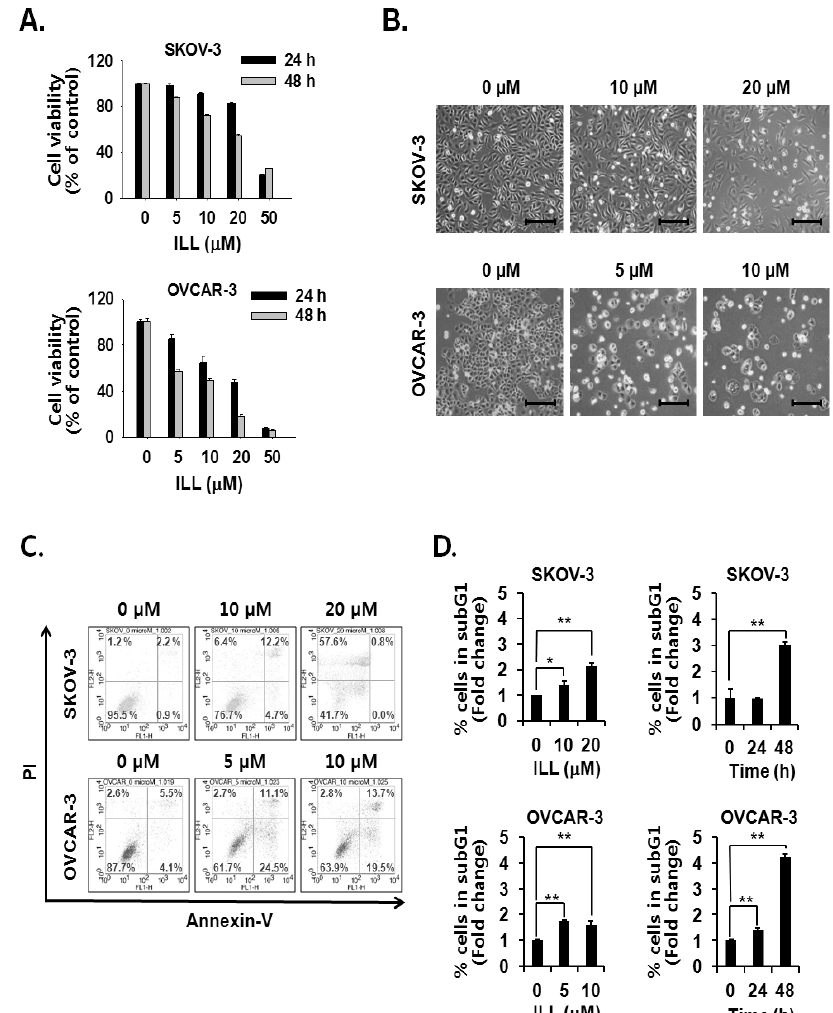
Figure 1. Cell death-inducing e ff ects of isolinderalactone (ILL) in human ovarian cancer (OC) cells. ( A ) ILL inhibited cell viability in a time- and dose-dependent manner. Cell viability was assessed with the water-soluble tetrazolium (WST) assay. ( B ) Morphological changes to SKOV-3 and OVCAR-3 cells in response to ILL treatment after 48 h. Microscopic images after 48 h. Scale bar = 200 µ m. Magnification, 100 × . ( C ) ILL increased the proportion of PI-positive SKOV-3 cells and Annexin V-positive OVCAR-3 cells. The data are presented as dot plots. ( D ) ILL enhanced the proportion of subG1 cells in both cell types. Data are presented as the mean ± SD. * p < 0.05 and ** p < 0.001 vs. the control